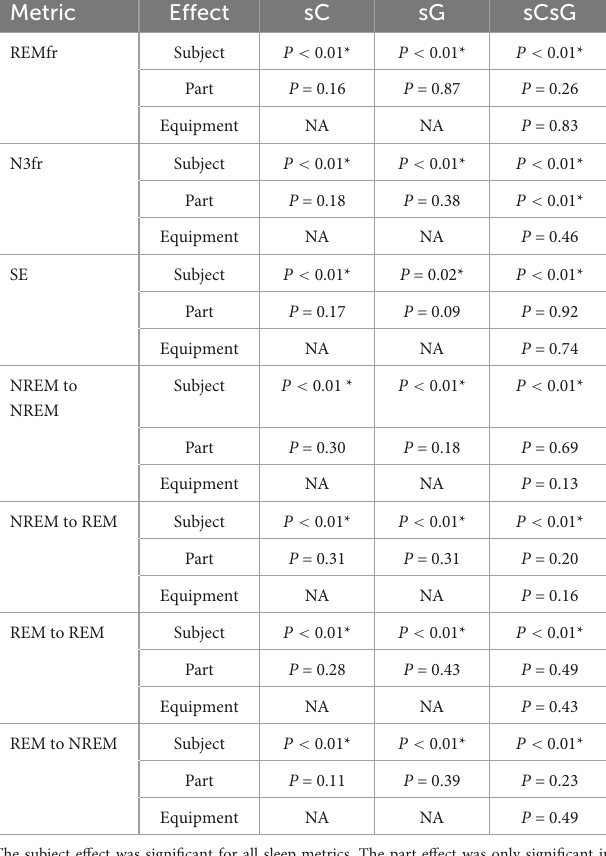
TABLE 2 Results from the linear mixed model (LMM) analysis on the sleep metrics.